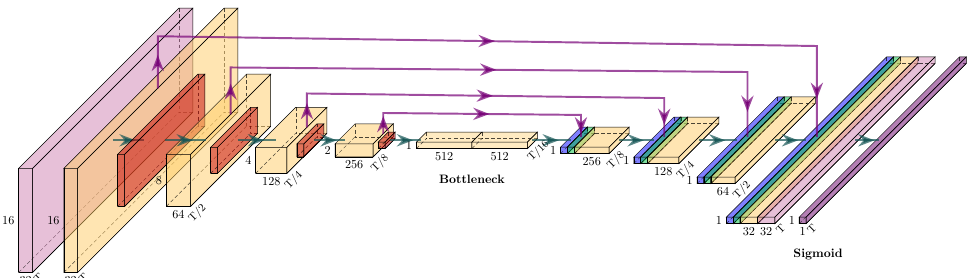
Figure 8. Definition of the Virtual Axle Detection model (VAD), with coloured boxes corresponding to the following layers: CB (light purple), RB (yellow), max pooling (red), concatenate (green), transposed convolution (blue), and reshaping skip connection (purple arrow). Dimensions of the output feature maps for the corresponding layer, with T samples at the bottom right, feature maps at the bottom, and frequencies at the left. The model dimensions for the input: 16 frequencies × 6 transforms × T samples; for the output: 1 × 1 pseudo-probabilities × T